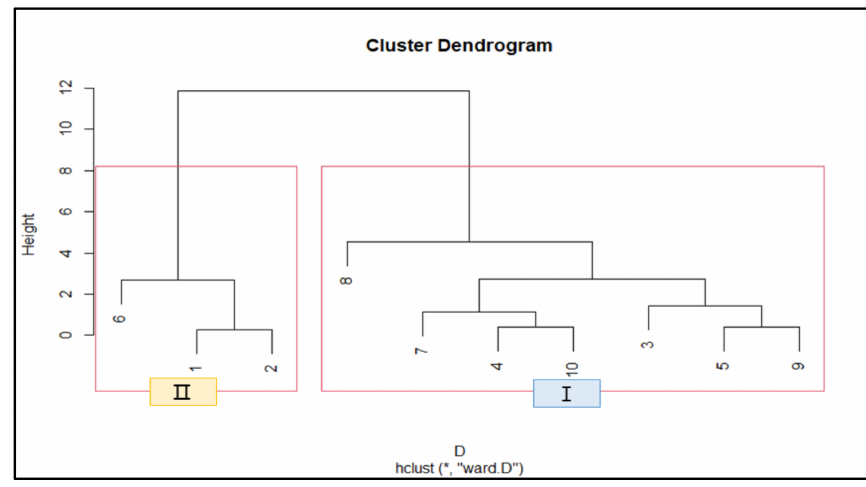
Figure 8. Result of reservoir characteristics through cluster